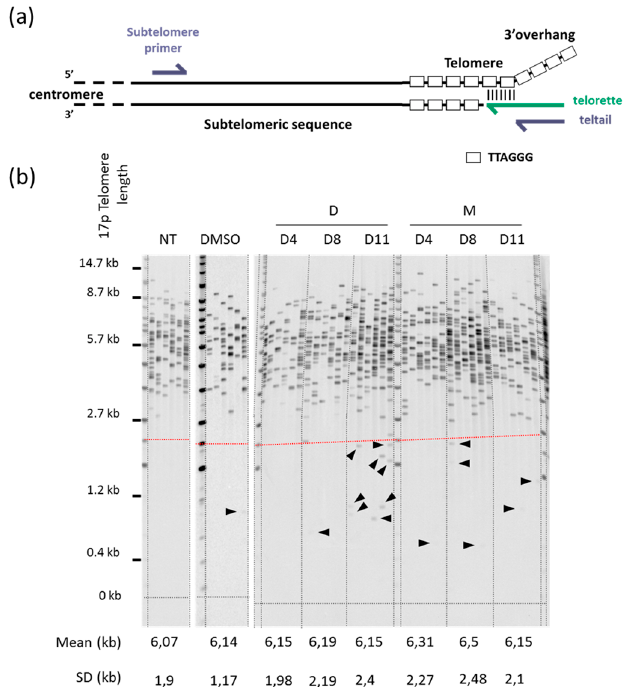
Figure 2. Treatment with 360A and (360A) 2A had no effect on mean telomere length: ( a ) Schematic representation of the principle of STELA [5]; ( b ) STELA at 17p telomere in non-treated A549 (NT), A549 treated with 0.1% DMSO (DMSO), 5 µ M 360A (M), or 5 µ M (360A) 2A (D) after 4, 8, and 11 days of treatment (D4, D8, D11) (representative STELA from experiment (1)). Each lane represents a PCR and each band a telomere. The mean and SD of the telomere length are shown below. Arrows show examples of telomere deletion events (TDEs) (i.e., telomeres shorter than 2.2 kb (red dashed line)).